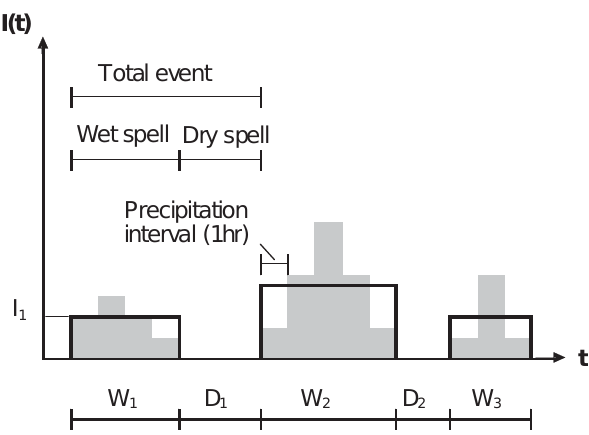
Fig. 1. Scheme of precipitation event time series (after Haberlandt et al., 2008).